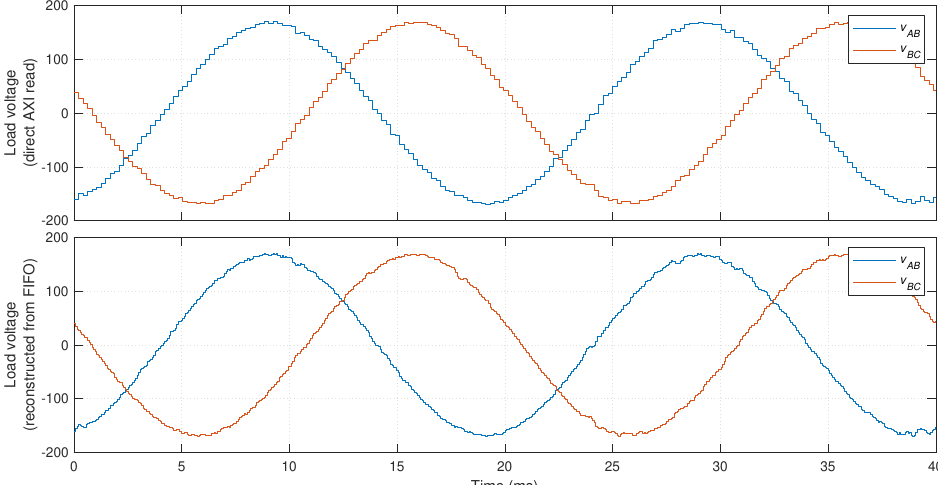
Figure 32. Load voltage waveforms acquired directly from the AXI interface and using the FIFO, for the same time